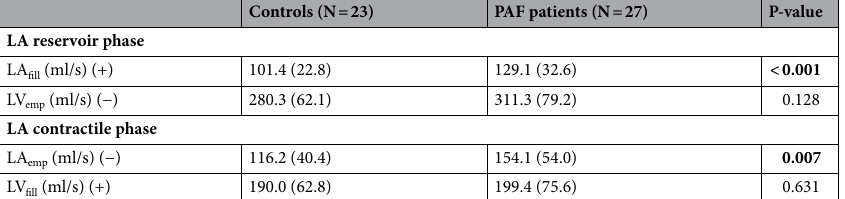
Controls (N = 23) PAF patients (N = 27) P-value LA reservoir